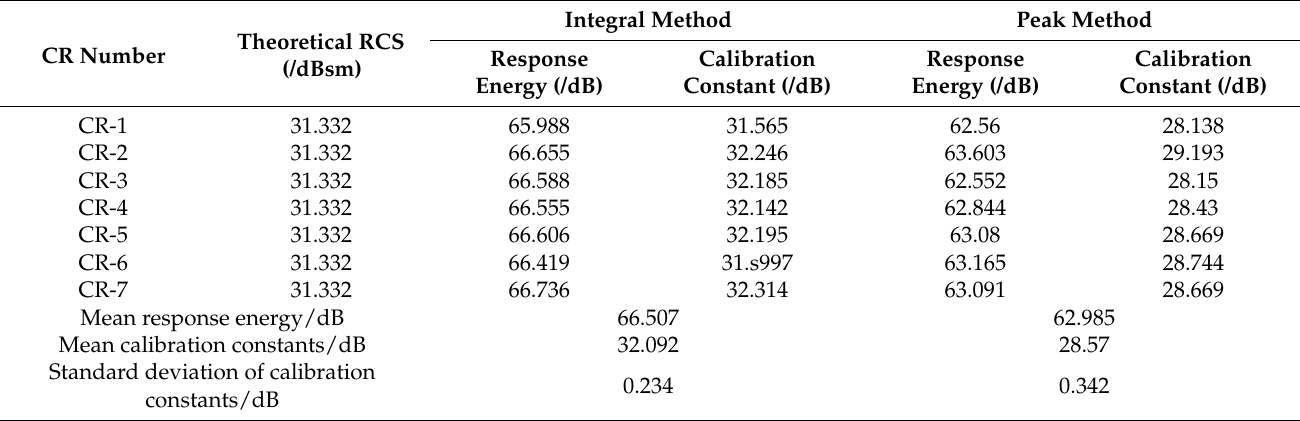
Table 6. Response energy and calibration constant results of each point target for UFS mode data on 12